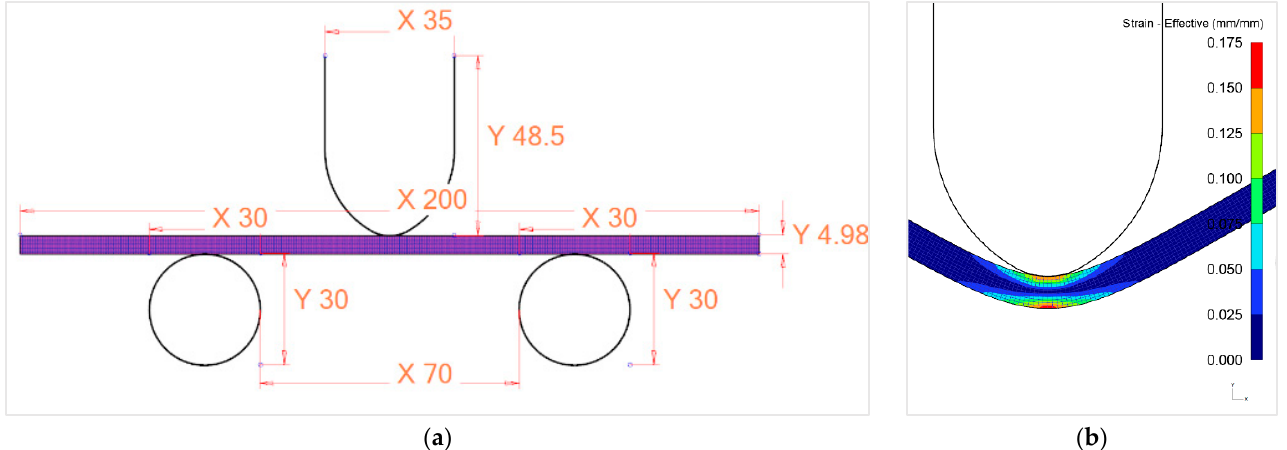
Figure 3. ( a ) The geometry and the mesh of the 2D FEM 3PB tests; ( b ) FEM simulation of effective strain distribution.